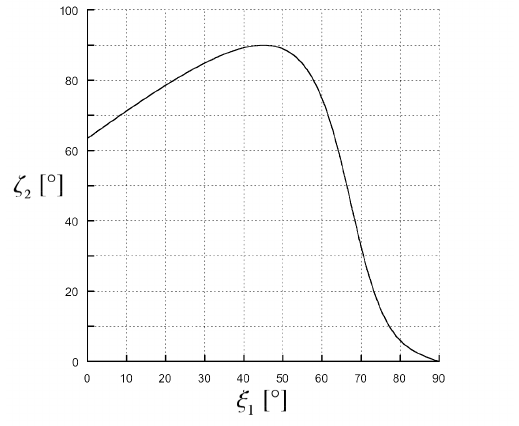
Figure 8. Transmitted angle of the attenuation vector, ζ 2 in degrees, as a function of the incident angle of the phase vector, ξ 1 in degrees. Medium 1 is a vacuum, medium 2 has ε (cid:48) The magnitude of the incident phase vector is the critical one in Equation (3) when ε (cid:48)